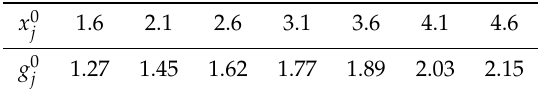
Table 1. Positive data set of values.